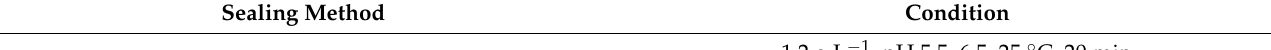
Table 2. Process parameters of sealing techniques applied to anodic oxide films (based on ref. [22]). Sealing Method Condition Cold sealing with nickel fluoride (NiF 2 )